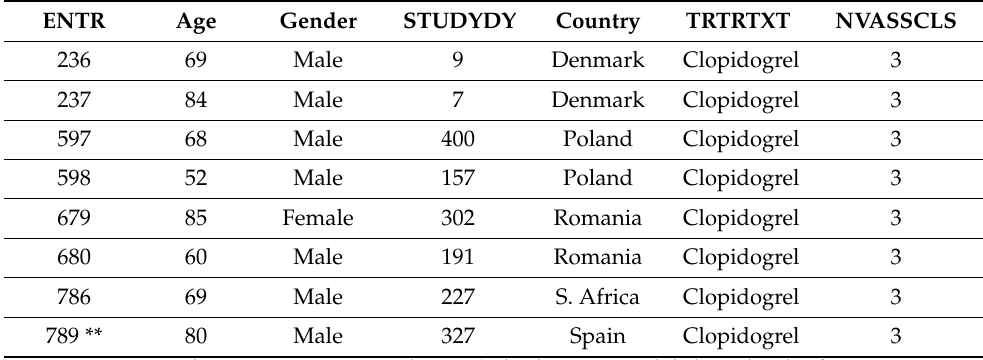
Table 1. Questionable cancer deaths in PLATO